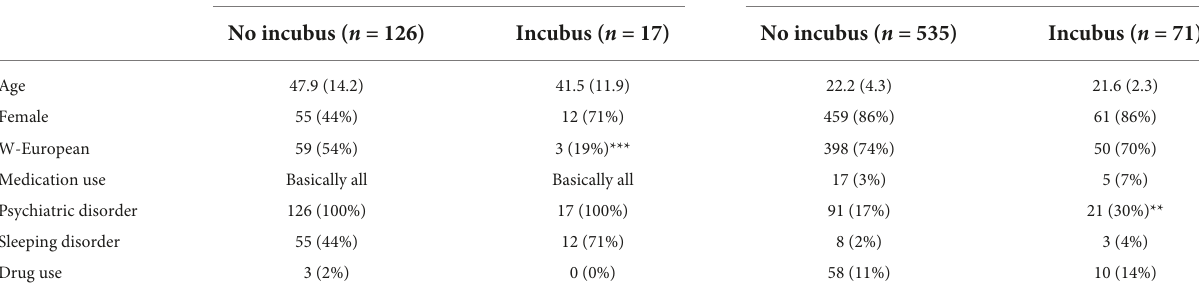
TABLE 1 The incubus phenomenon and associated